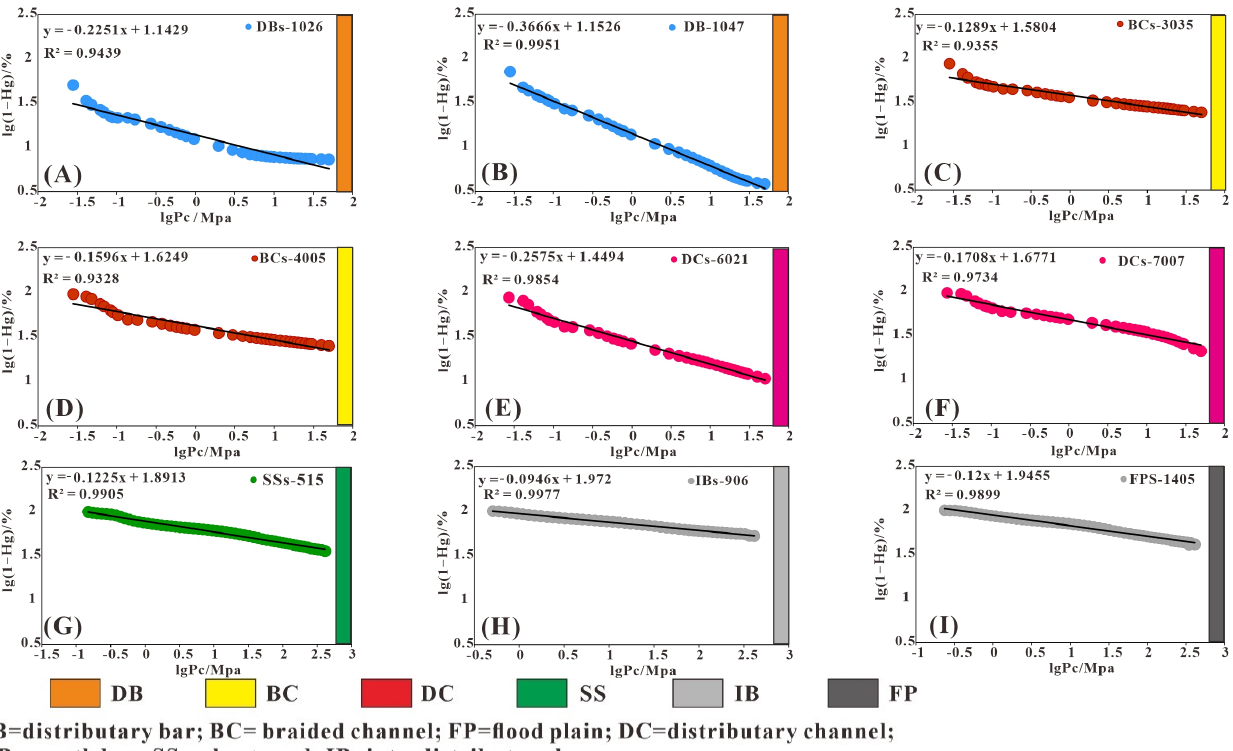
Figure 14. Representative sample plots of lg(Pc) vs. lg(1 − Hg). The correlation coefficients (R 2 ) of all the graphs were greater than 0.9, indicating that the samples conform to fractal characteristics. As the quality of the reservoir deteriorates, the fractal dimension gradually increases. ( A ) Fractal di- mension of DB. ( B ) Fractal dimension of DB. ( C ) Fractal dimension of BC. ( D ) Fractal dimension of BC. ( E ) Fractal dimension of DC. ( F ) Fractal dimension of DC. ( G ) Fractal dimension of SS. ( H ) Frac- tal dimension of IB. ( I ) Fractal dimension of FP.